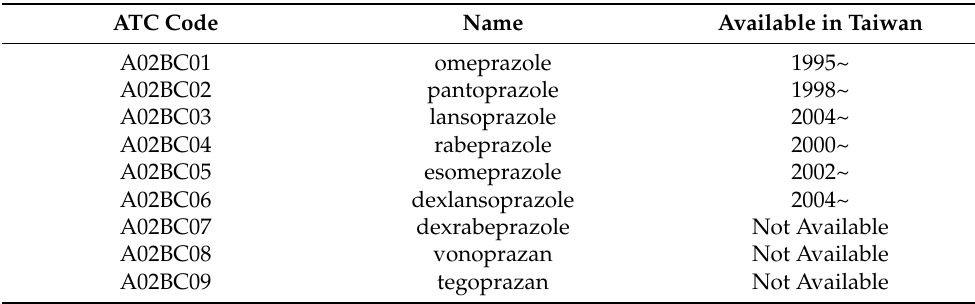
Table A1. The PPIs classification using Anatomical Therapeutic Chemical (ATC) code A02BC. ATC